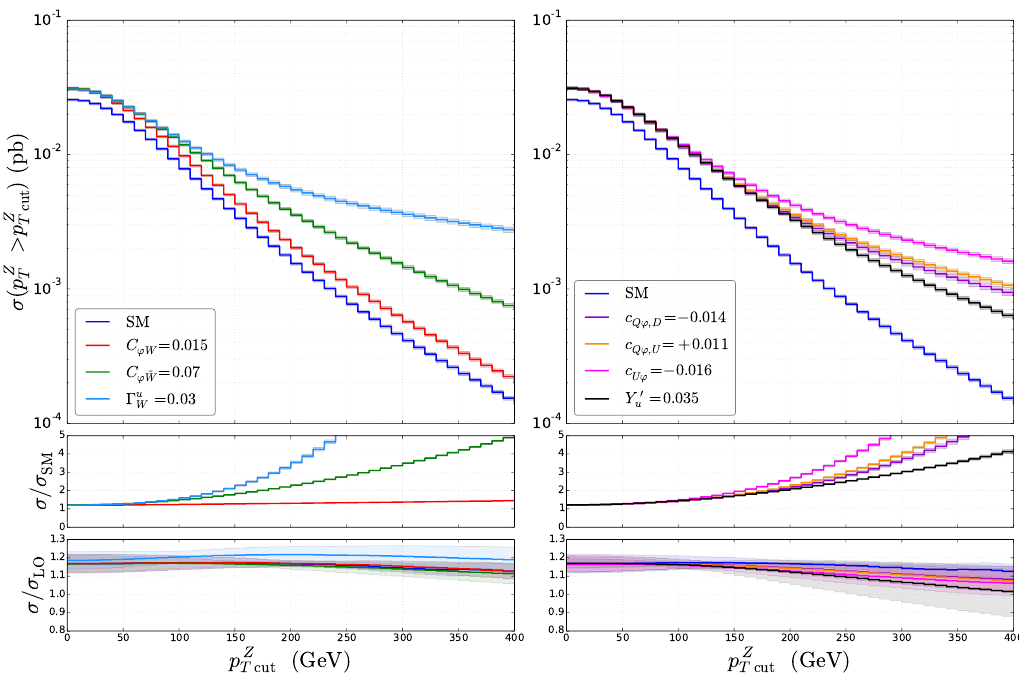
p Figure 5 . Cumulative ZH production cross section for p Z > p Z , at S = 13 TeV. T T cut using the PDF4LHC15 nlo 30 PDF sets. For the operators we considered the theoretical uncertainties are around 5%-10%, and roughly independent on the value of p Z . The T cut middle panel of (cid:12)gure 5 shows that for all dimension-six operators the contribution to the cross section increases at large p . The increase is most marked for the dipole T